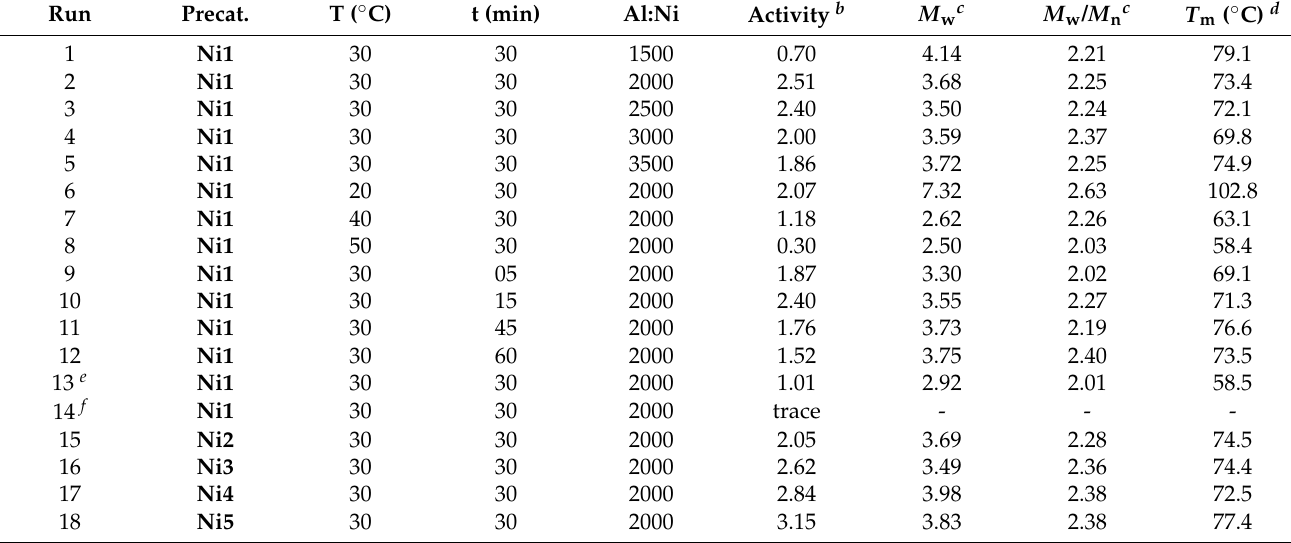
Table 4. Polymerization results using Ni1–Ni5 and MMAO a